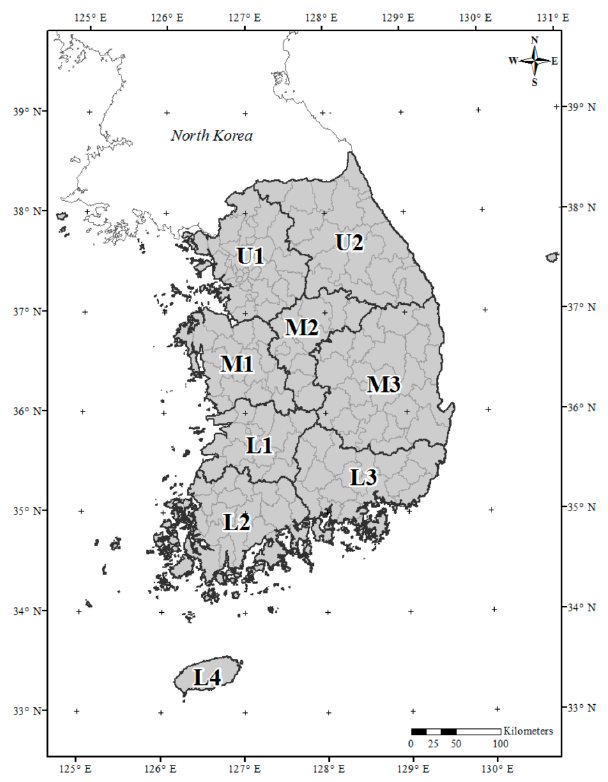
Figure 3. The nine regions corresponding to provinces (U1: Gyeonggi, U2: Gangwon, M1: Chungcheongnam, M2: Chungcheongbuk, M3: Gyeongsangbuk, L1: Jeollabuk, L2: Jeollanam, L3: Gyeongsangnam, and L4: Jeju). Table 5. Temporal and regional averages and standard deviations of Rainfall Effectiveness Index for Paddy fields (REIP).